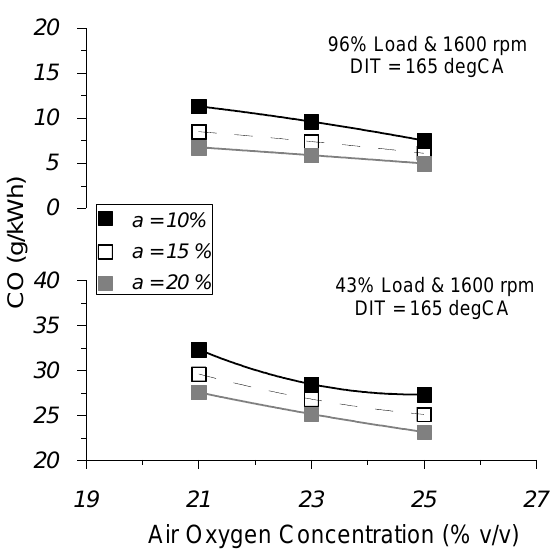
Figure 13. Calculated specific CO concentration versus “inlet-air oxygen ratio” for various “diesel fuel quantity ratios”, at 43% and 96% of engine rated load and 1600 rpm engine speed, for DIT = 165 degCA.